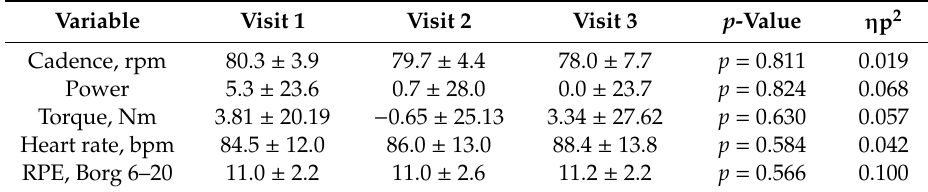
Table 2. Cycling physiological